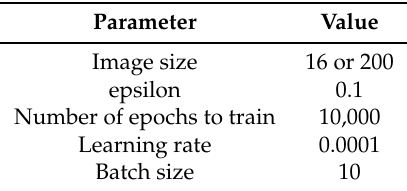
Table 5. DQN training parameters.